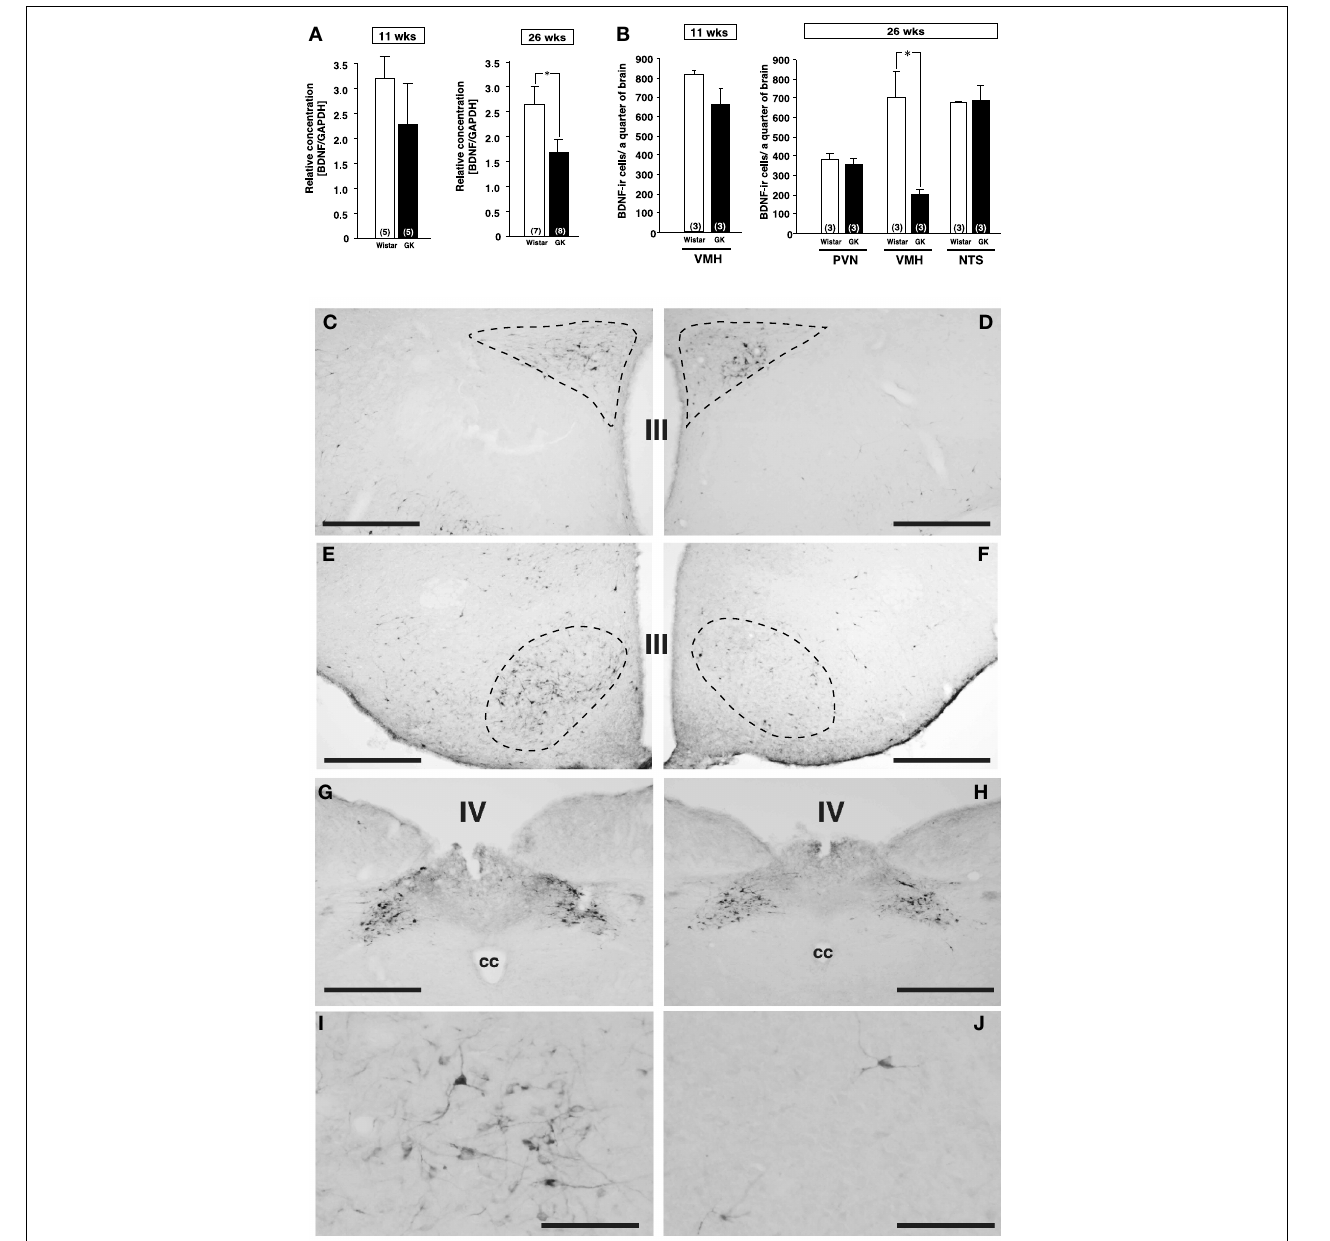
FIGURE 1 | Expressions of BDNF mRNA and BDNF-immunoreactive cells in Wistar and GK rats at 11 and 26 weeks of age. (A) BDNF mRNA levels in VMH of Wistar and GK rats. Significant reduction of BDNF mRNA level was found in GK rats at 26 weeks of age ( ∗ p < 0 . 05, Student’s t -test). (B) At 26 weeks, significant reduction of the number of BDNF-immunoreactive neurons was found in VMH, but not PVN and NTS, of GK rats ( ∗ p < 0 . 05, Two-Way ANOVA with Tukey’s post-hoc test). This reduction in VMH was not different at 11 weeks. (C–J) Representative images of BDNF-immunoreactive